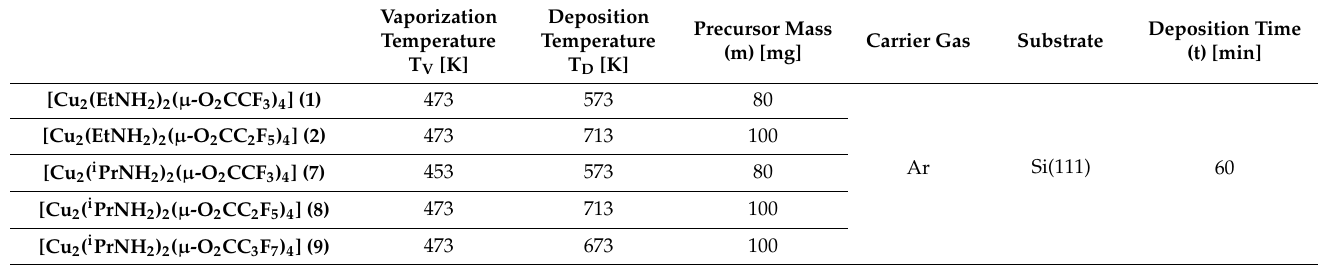
Table 6. Summary CVD conditions for experiments.